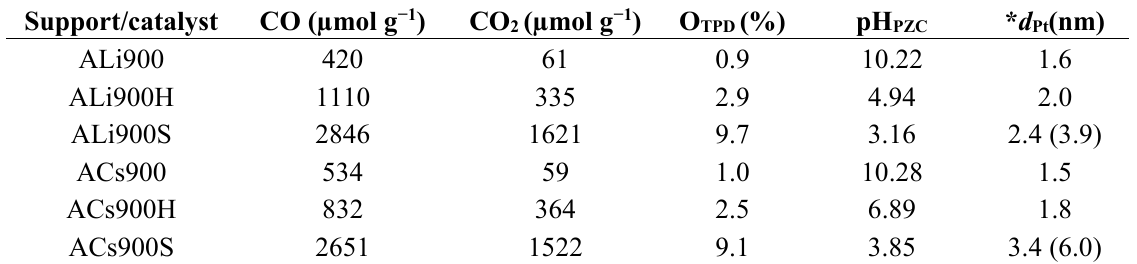
Table 5. Amounts of CO and CO 2 evolved up to 1000 °C and oxygen content (O TPD ) from TPD experiments, measurements of pH PZC and mean Pt particle size for the derivatives